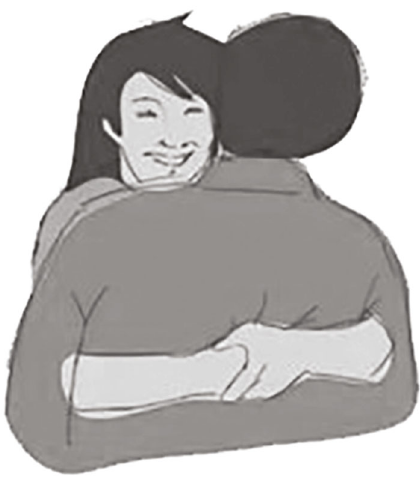
Figure 3: Diagram of face-to-face hugging at the waist.